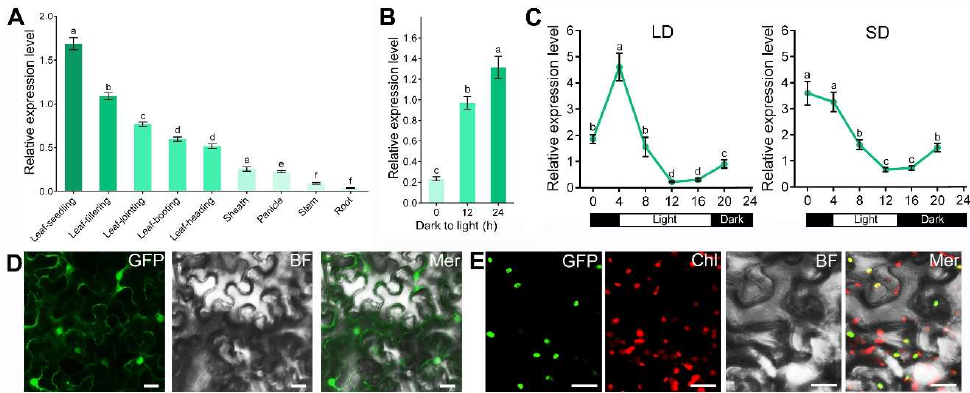
Figure 6. The expression pattern and subcellular localization of YE1. ( A ) YE1 expression levels in different tissues. ( B ) YE1 expression levels during light-induced greening of WT etiolated seedlings. After growing in darkness for 10 days, etiolated WT seedlings were illuminated for 12 or 24 h. ( C ) Rhythmic expression of YE1 under LDs and SDs. ( D ) Subcellular localization of GFP protein (control). ( E ) Subcellular localization of YE1–GFP fusion protein. BF, bright field; Chl, chloroplasts’ auto-fluorescence; Mer, merge of each channel. Bars = 10 µ m. Each value is given as means ± SEM ( n = 3). Different letters indicate the statistical differences at p < 0.05 by Duncan’s